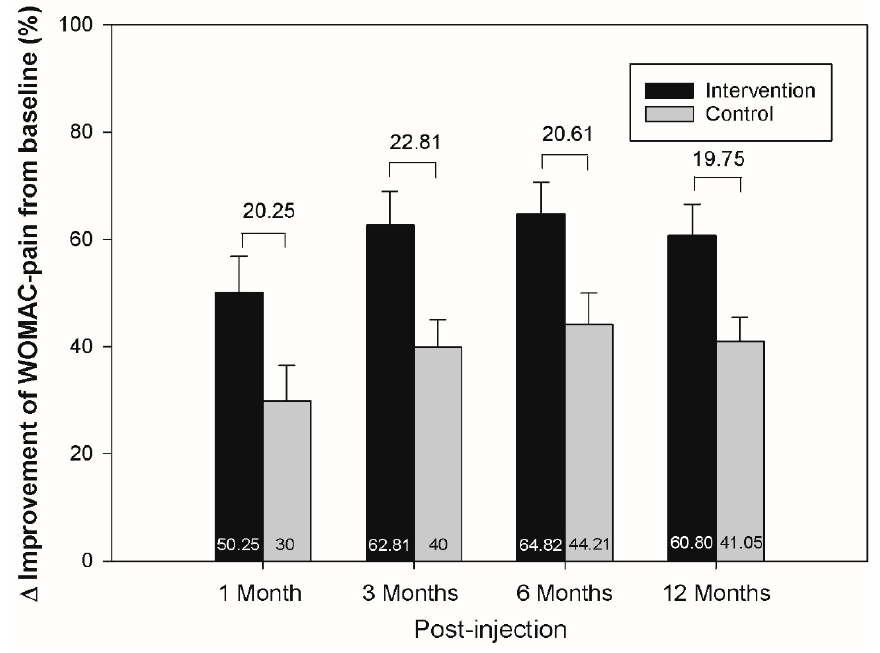
Figure 2. Differences (%) in Western Ontario and McMaster Universities Osteoarthritis Index (WOMAC) pain scores, between post-injection and baseline, in both groups at each time point. There were greater improvements in the intervention group. The intergroup differences ranged from 19.75% to 22.81%. The upper whiskers represent standard errors. Table 3. Proportion of study subjects meeting the MCID of WOMC between Table 2. Comparison of all WOMAC scores between both groups.